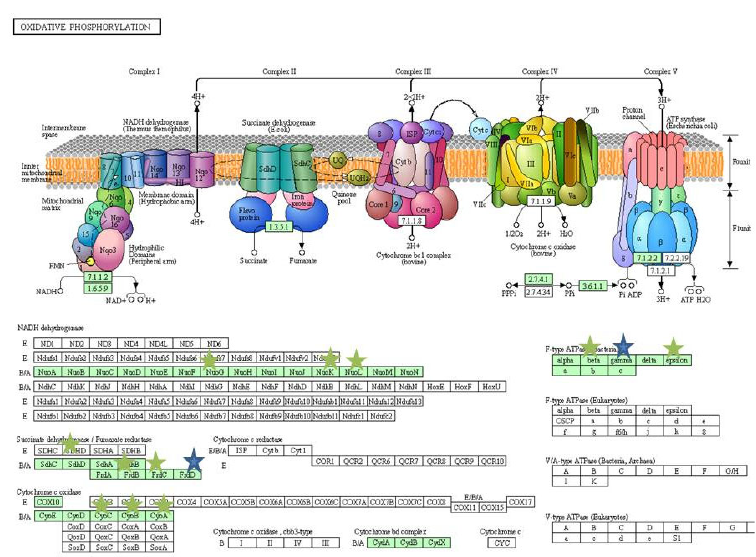
Figure 11. Oxidative phosphorylation (KEGG database). Blue stars represent the downregulated genes in bile and bile antibiotic treatment, green stars represent the genes downregulated in only bile antibiotic treatment.